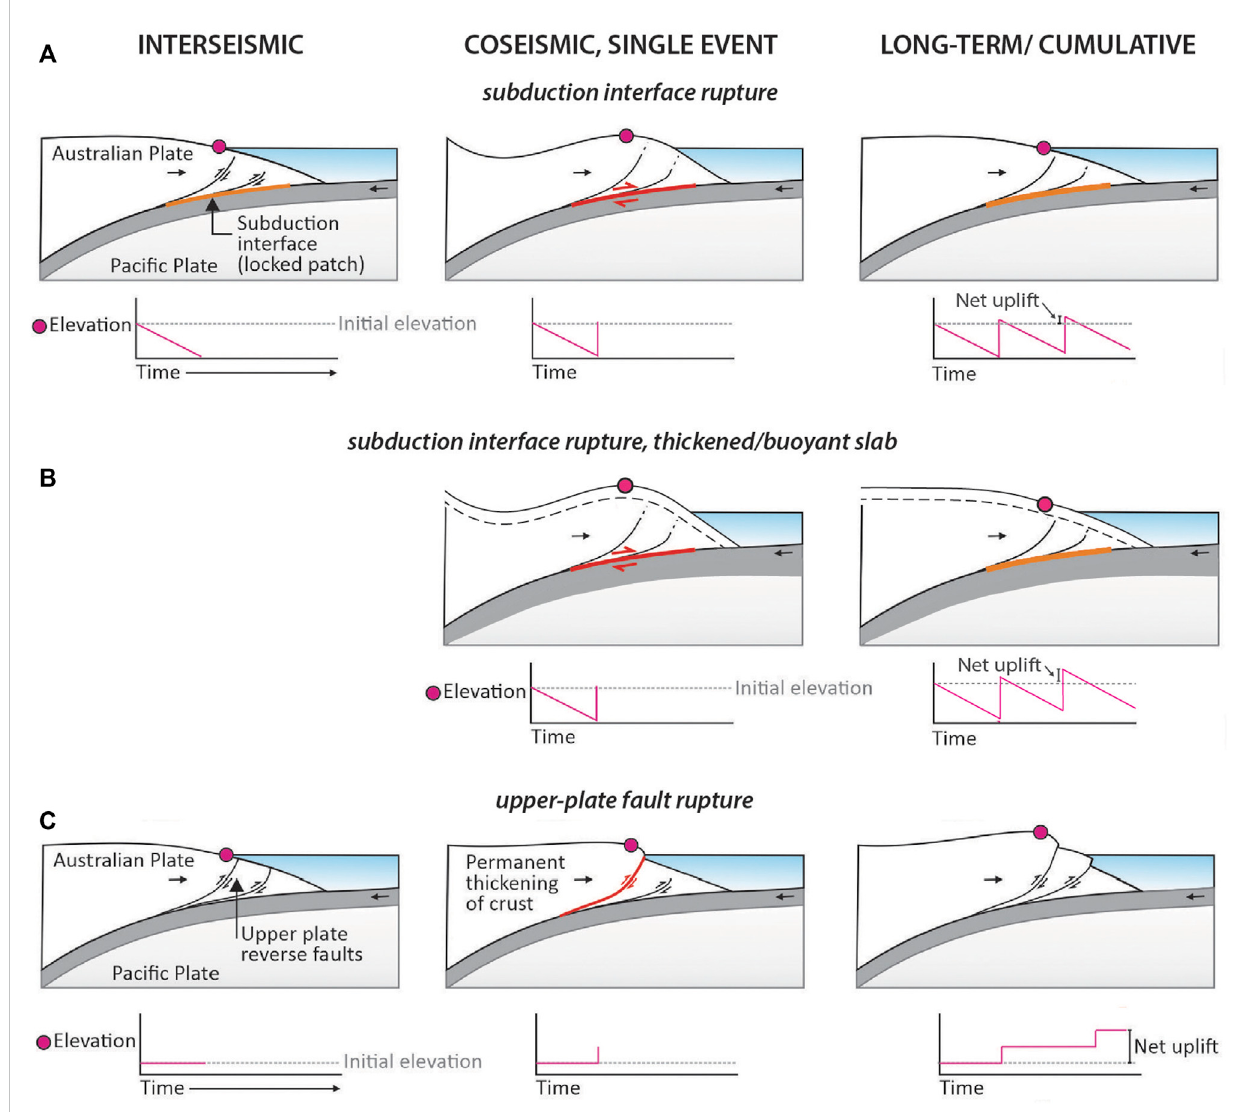
FIGURE 3 Possible causes of long-term vertical deformation at the Hikurangi Margin, and their likely expression: (A) subduction interface rupture; (B) subductioninterfaceruptureinvolvingathickenedbuoyantHikurangiPlateau(dashedlinedepictsverticaldeformationwithoutthedown-goingbuoyant slab); (C) upper-plate fault rupture. Figure modi fi ed after Howell and Clark